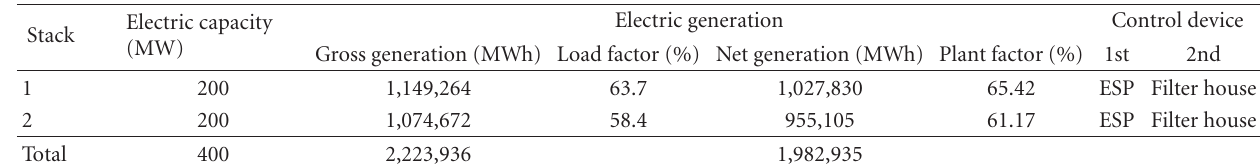
Table 1: Status of power generation of anthracite-fired fluidized bed plants and air-pollution control facilities (2005. 1.1. ∼ 12.31.). Stack